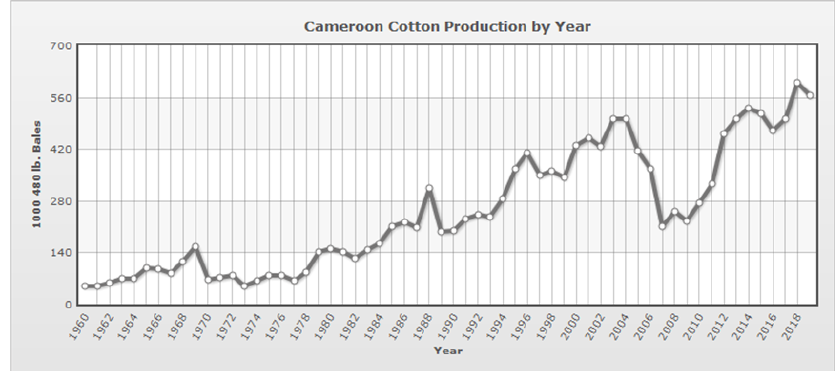
Figure 1: Cameroon Cotton Production from